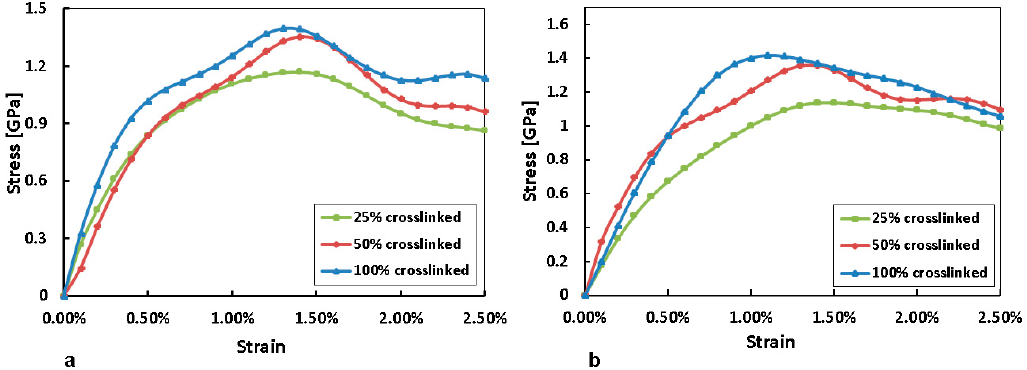
Figure 6. Graph of stress versus strain at different crosslink % ( a ) tensile strength; ( b ) compressive strength.